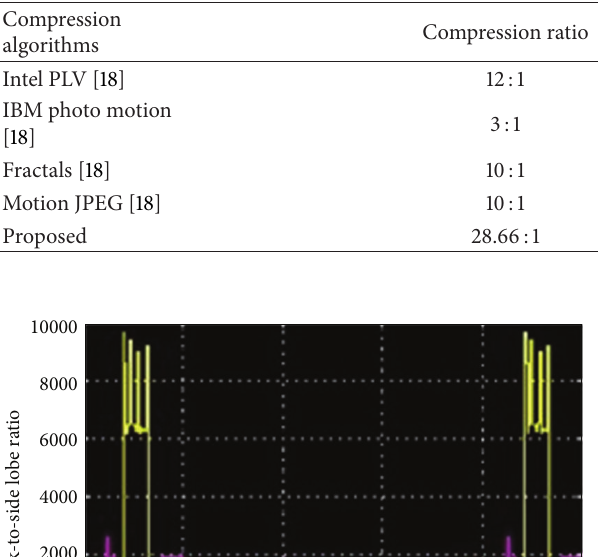
Table 2: Comparison of compression ratio of proposed algorithm with other algorithms.